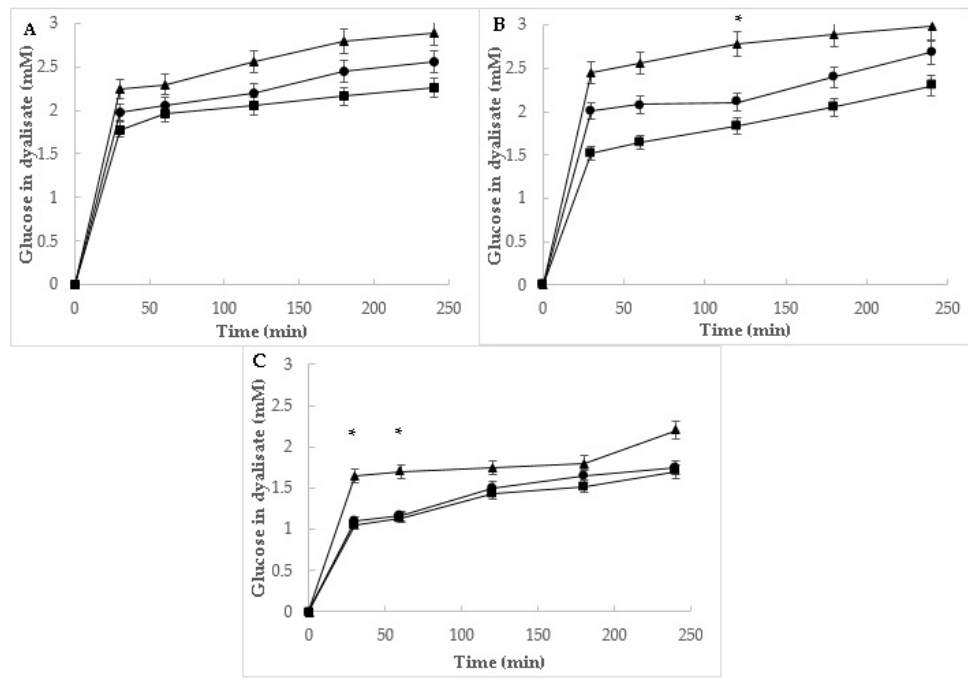
Figure 3. Effect of different amounts (0.25 g, ▲ ; 0.5 g, ● ; and 1.0 g, ■ ) of mistol powders on glucose diffusion: ( A ) seed, ( B ) pulp, and ( B , C ) skin powders. Results are expressed as the mean of three independent tests with SEM. The symbol * at a given time indicates significant differences ( p ≤ 0.05) between the glucose content in the dialysate between the three amounts of mistol powder, according to Tukey’s test.